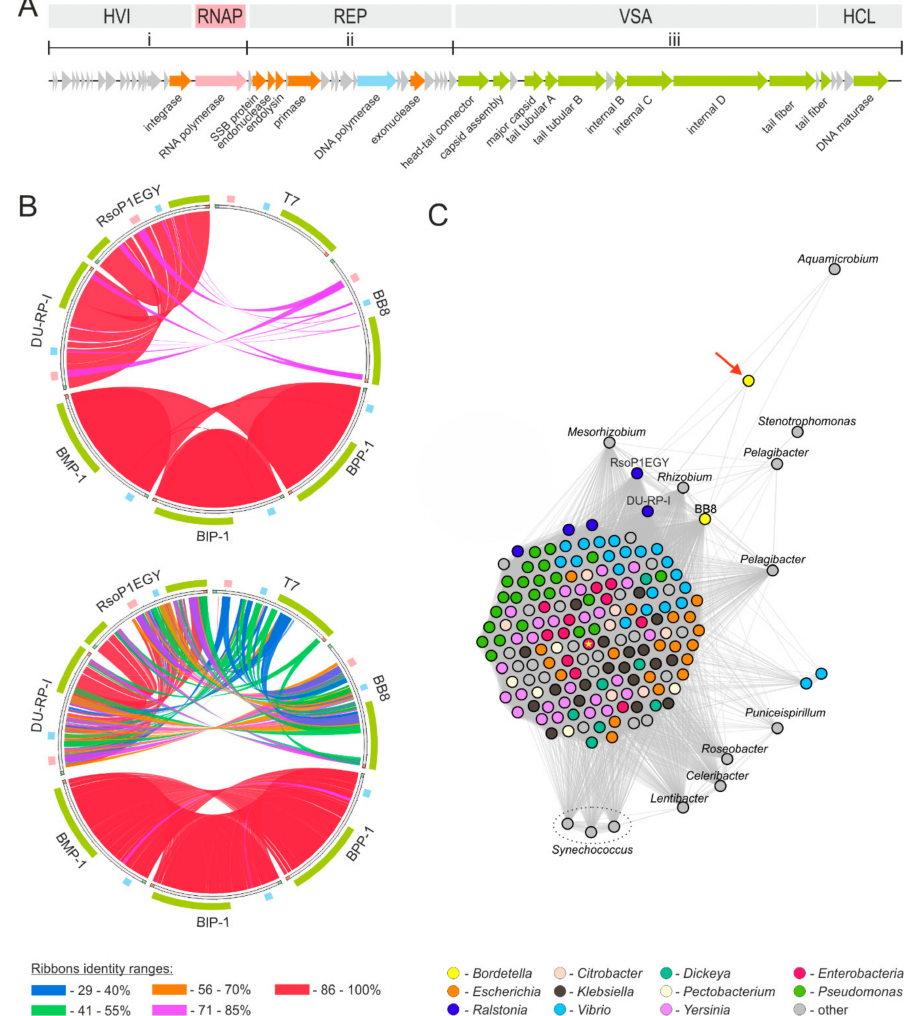
Figure 5. Genome organization and comparative genomics of BB8 phage. ( A ) Genome organization of BB8. A block at the top shows host-virus interaction (HVI), RNA polymerase (RNAP), DNA replication (REP), virus structure and assembly (VSA) and host cell lysis (HCL) modules, as well as transcription of genes of class i, ii, and iii. The modules were identified and described with the use, and according to, the genome organization of the model phage T7. The arrows below represent open reading frames identified in the BB8 genome and their transcriptional orientation. The coloring scheme of the arrows is as follows: grey—hypothetical proteins with unknown function, orange—proteins with predicted function, pink—RNA polymerase, blue—DNA polymerase, green—virus structure and assembly proteins. ( B ) The comparison of BB8 sequences with those of T7 phage of Enterobacteria (NC_001604), two most similar Ralstonia phages, i.e., RsoP1EGY (MG711516) and DU-RP-I (MF979559), and all known podoviruses infecting Bordetella , i.e., BMP-1 (AY526908), BIP-1 (AY526909), and BPP-1 (AY029185). The comparison was performed with the Circoletto tool on nucleotide (top graph) and amino acid (bottom graph) sequence levels. The blocks on the outmost ring correspond to the location of RNAP, DNA polymerase, and VSA modules. The colors of these correspond to the colors in panel A. ( C ) Sequence similarity network of proteins encoded by BB8 and the most closely related bacterial viruses. Each node represents a single phage genome and each edge, and its thickness, reflects the number of similar proteins encoded by two phages above the set thresholds. The coloring is based on the host’s family taxonomy. Enterobacteria T7 phage’s node is additionally indicated with a yellow star. All viruses within the presented network belong to Podoviridae family except the Bordetella phage vB_BbrM_PHB04 (MF663786) annotated as a member of Siphoviridae family—indicated by the red